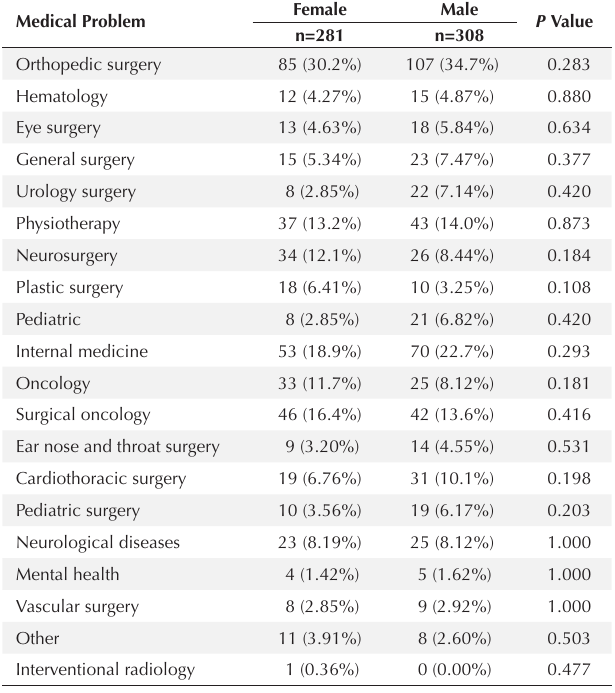
Table 4. Comparison of Medical Probems Between Males and Females Medical Problem